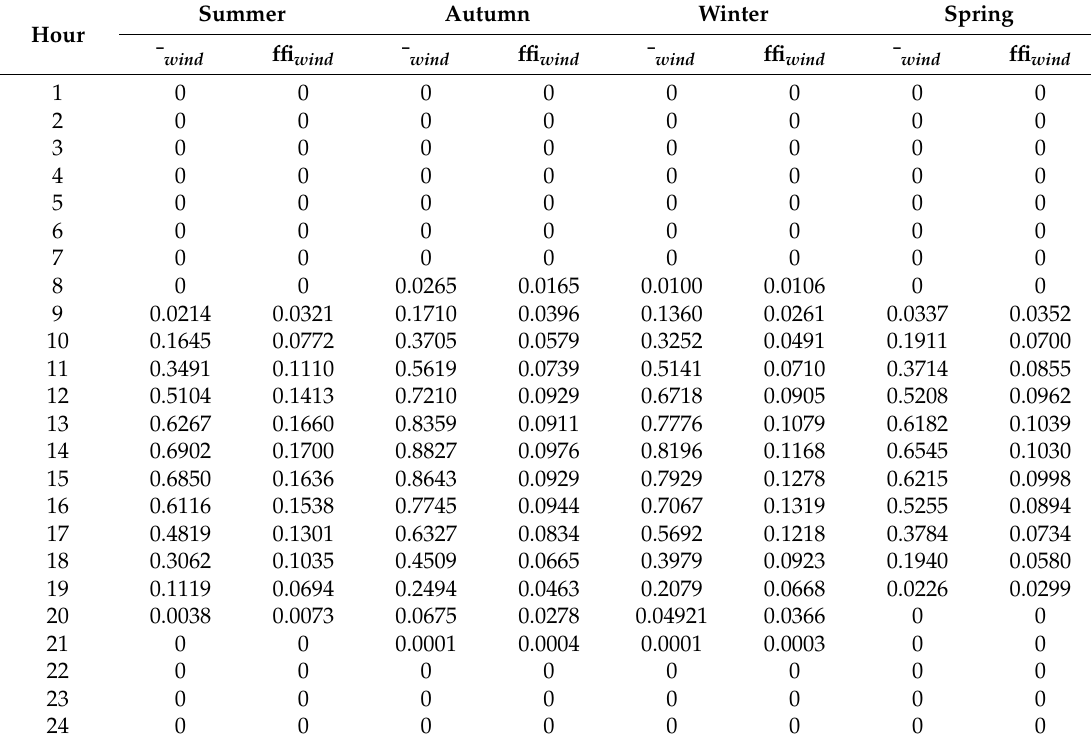
Table 3. Mean and standard deviation for solar irradiance in (kW/m 2 ).